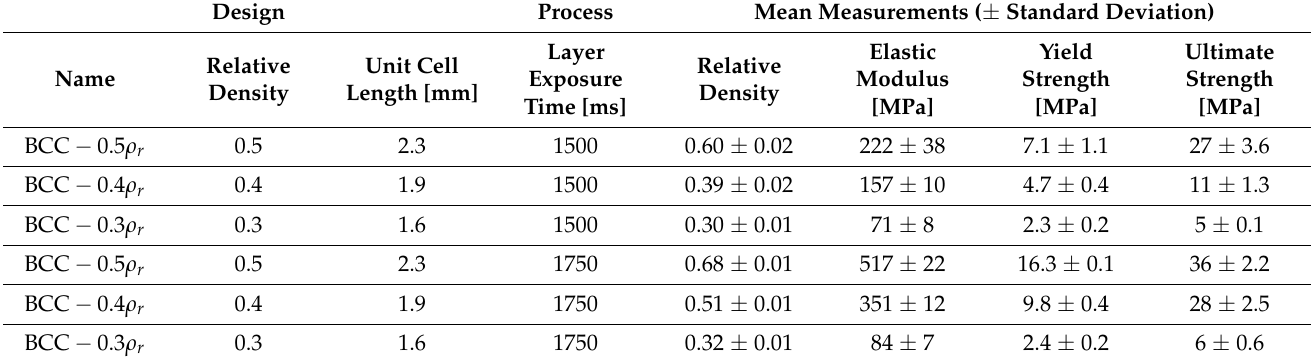
Table 3. Design and mean measured properties of lattices. All lattices have BCC topology with 500 µ m beam